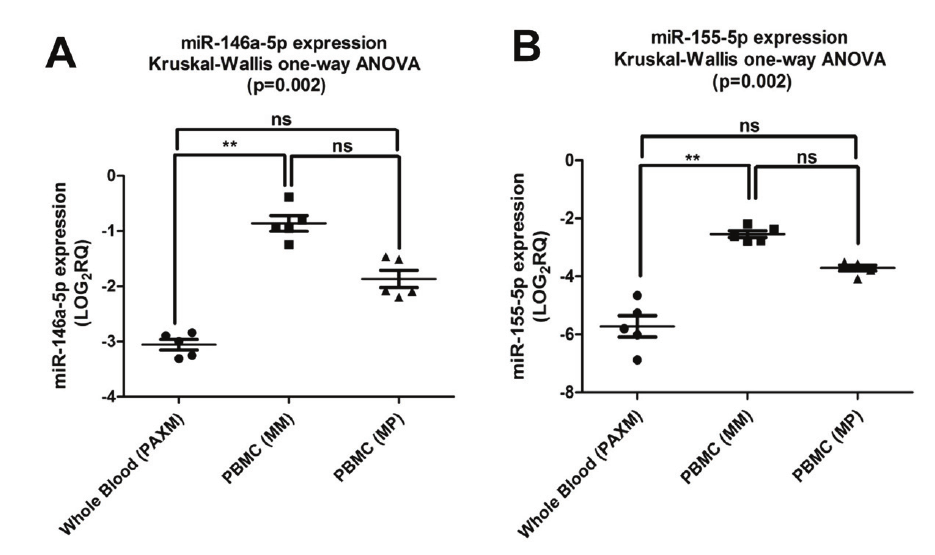
Figure 7. Normalised miRNA expression comparison from whole blood and PBMCs. ( A ) miR-146a-5p and ( B ) miR-155-5p expression. MicroRNA expression is significantly varied across all the three different groups (p=0.002). MicroRNA expression is higher in PBMCs extracted via either MP or MM method in comparison to whole blood. **p<0.01 and ns: not